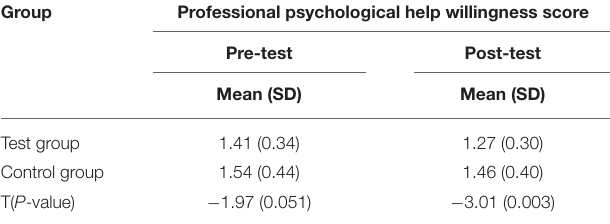
TABLE 6 | SCL90 test